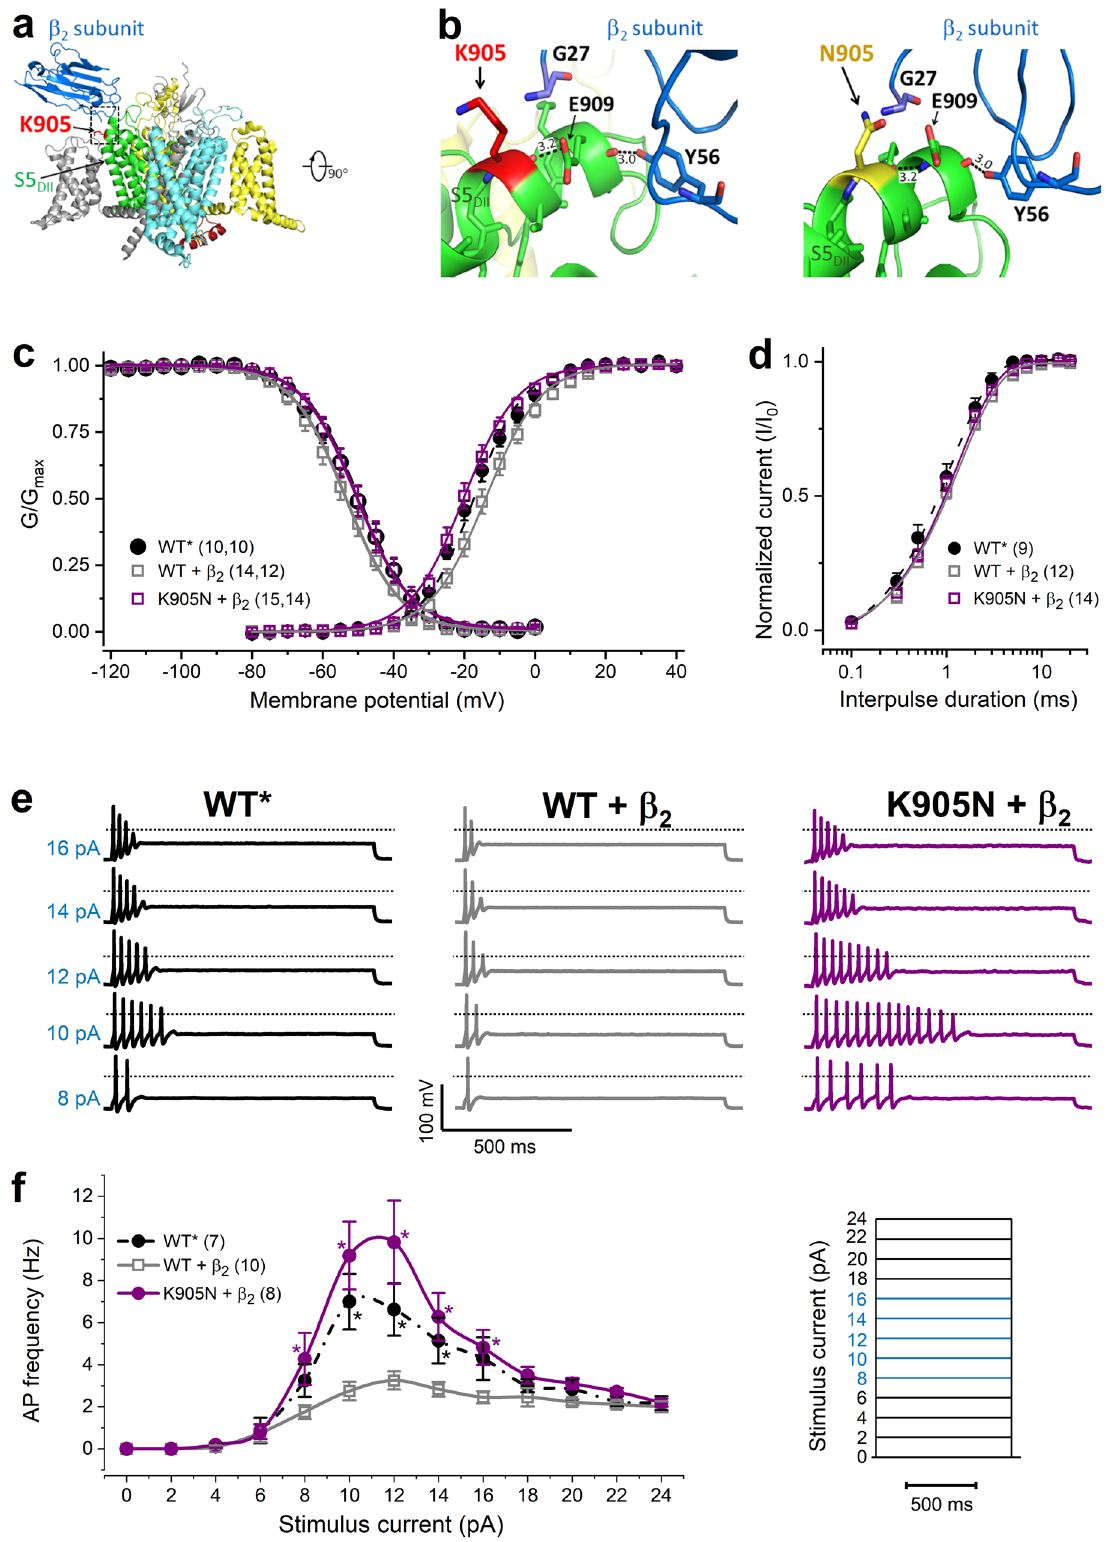
3D structural modeling . To better understand the molecular basis for the functional data from voltage clamp and DAPC assays, we mapped the variants onto a 3D model of the Na v 1.2 channel 24 . The detailed views of the channel, the predicted structural changes due to the mutated residues, and the inter- pretations of the effects caused by these modi fi cations are detailed